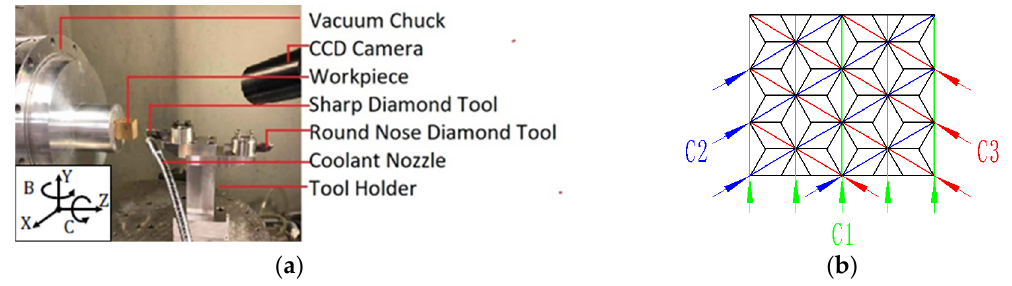
Figure 4. Ultra-precision single-crystal diamond cutting system: ( a ) Clamping mode of the workpiece and tool, ( b ) feed direction.